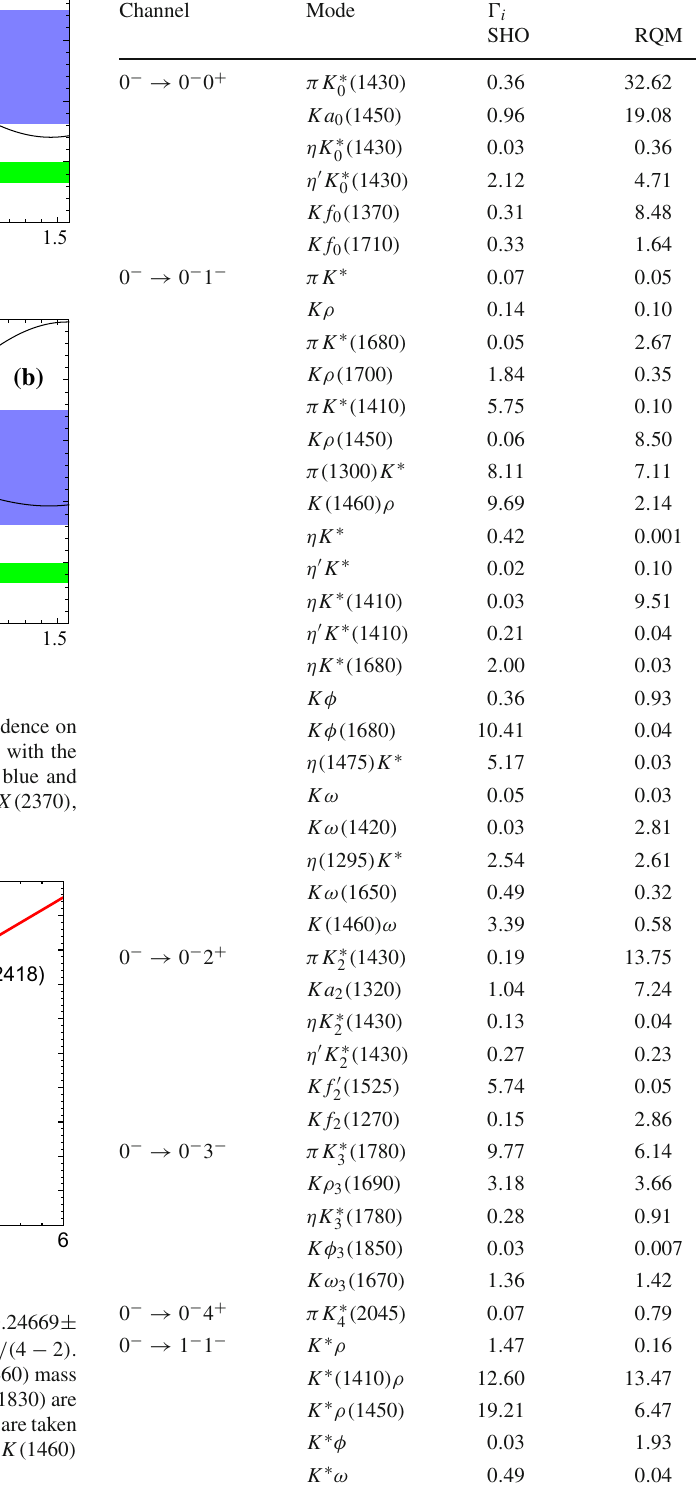
Table 6 Decay widths of the K ( 2418 ) as the 5 1 S 0 state in the 3 P 0 model with two types of wave functions (in MeV). The initial state mass is set to 2418